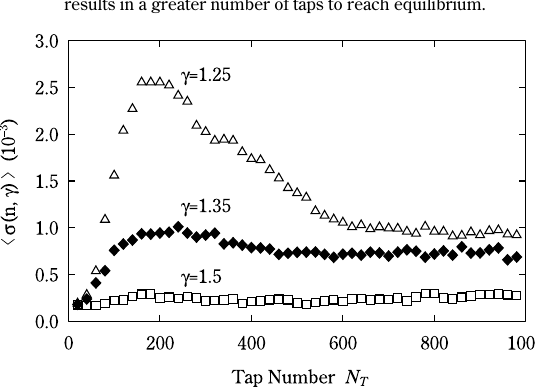
Fig. 6 The number of taps required to attain 99.5% of equilibrium bulk solids fraction versus the tap intensity γ . A reduction of γ results in a greater number of taps to reach equilibrium.